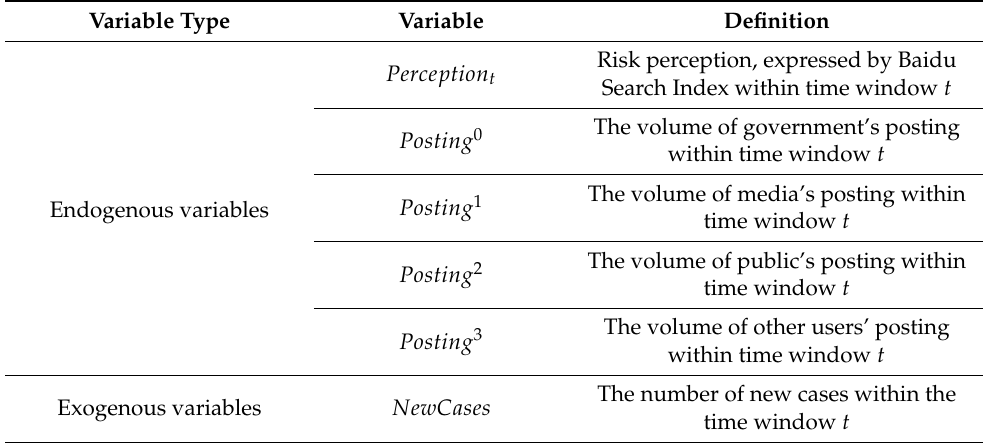
Table 3. Definition of variables.